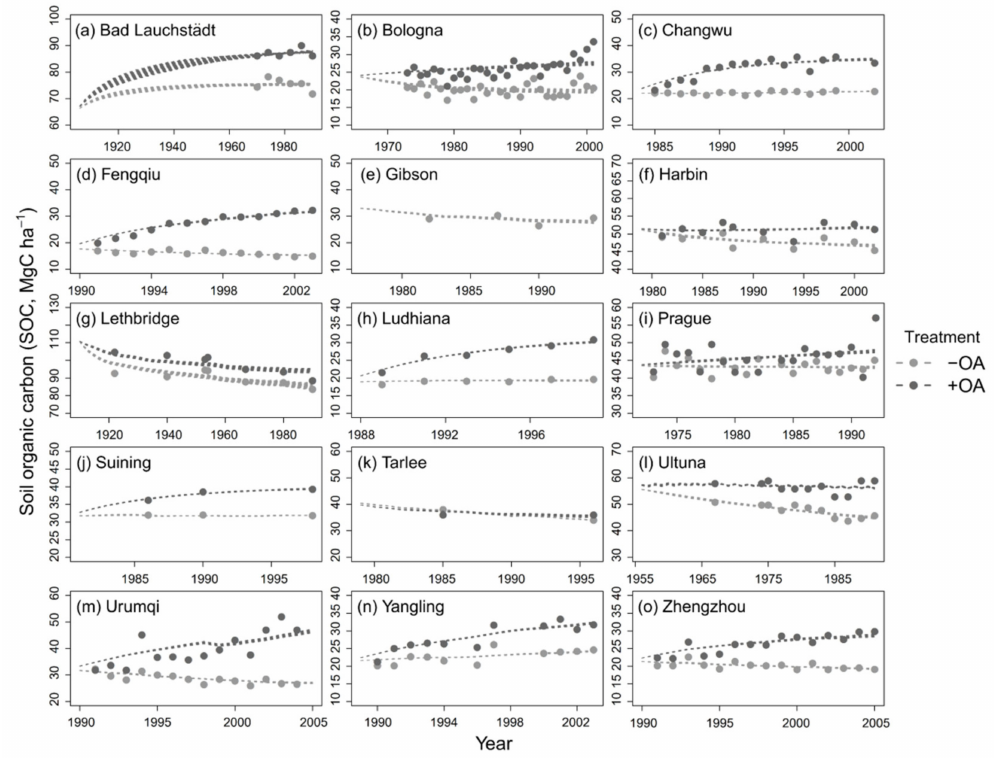
Figure 4. The temporal changes in soil organic C (SOC) simulated using the optimized best 100 combinations of model parameters. − OA: treatments without or with less organic amendment; +OA: treatments with or with more organic amendment. Dashed lines are the predicted temporal changes in SOC using the 100 optimized combinations of model parameters (see Model optimization section). Dots show the